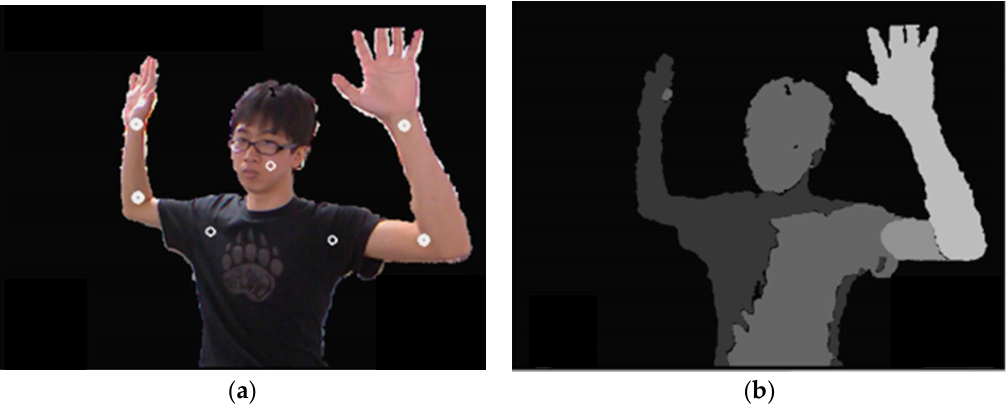
Figure 14. Results before and after arm point correction: ( a ) before arm point correction and ( b ) after arm skeleton point correction.